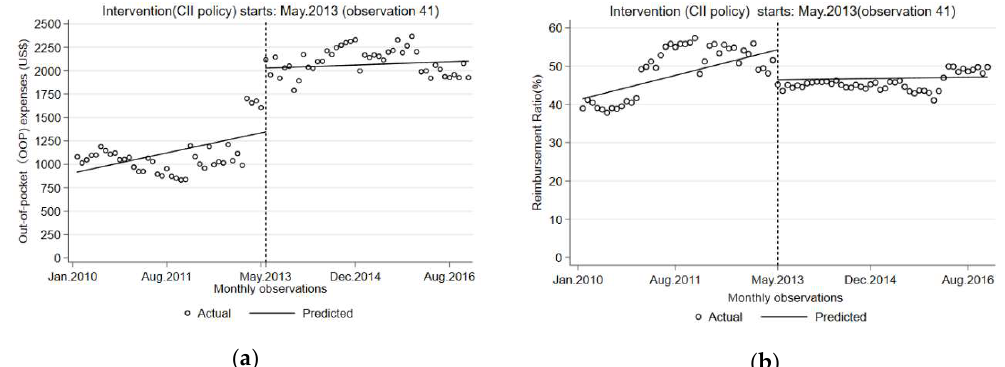
Figure A1. Graphical demonstration of interrupted time series (ITS) analysis. (a) CII policy effect on OOP expenses; (b) CII policy effect on Reimbursement Ratio (RR).